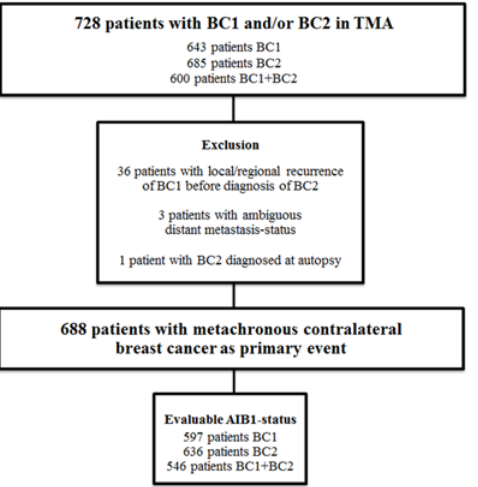
Fig 1. Flow-chart of inclusion vs . exclusion in the study cohort. In analysis 36 patients with a local/ regional recurrence of BC1 before diagnosis of BC2 were excluded in order not to confuse the results by eventual treatment given for the recurrence. We also excluded 3 patients with ambiguous distant metastasis- status and 1 patient with BC2 diagnosed at autopsy. Abbreviations: AIB1 Amplified in breast cancer 1 , BC1 f irst breast cancer , BC2 second breast cancer , TMA tissue